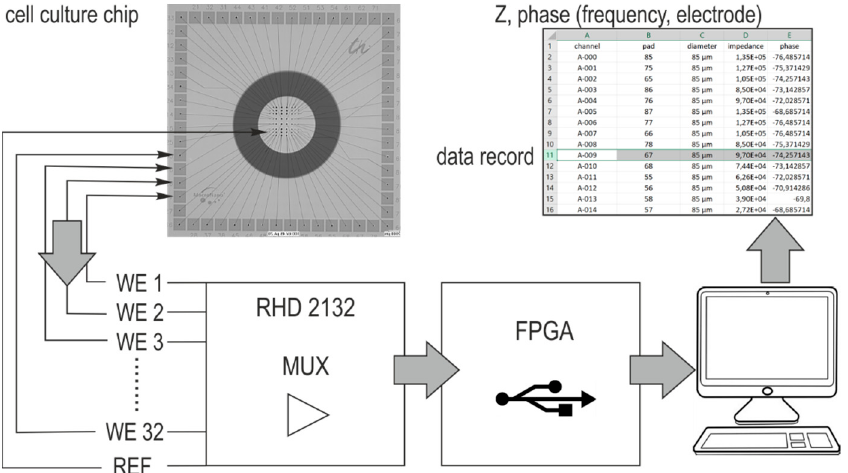
Figure 3. Schematic of the impedance measurement setup. RHD 2132: chip for recording of biopotential signals, WE = working electrode, REF = reference electrode, MUX = multiplexer, FPGA = field-programmable gate array board, Z = impedance.